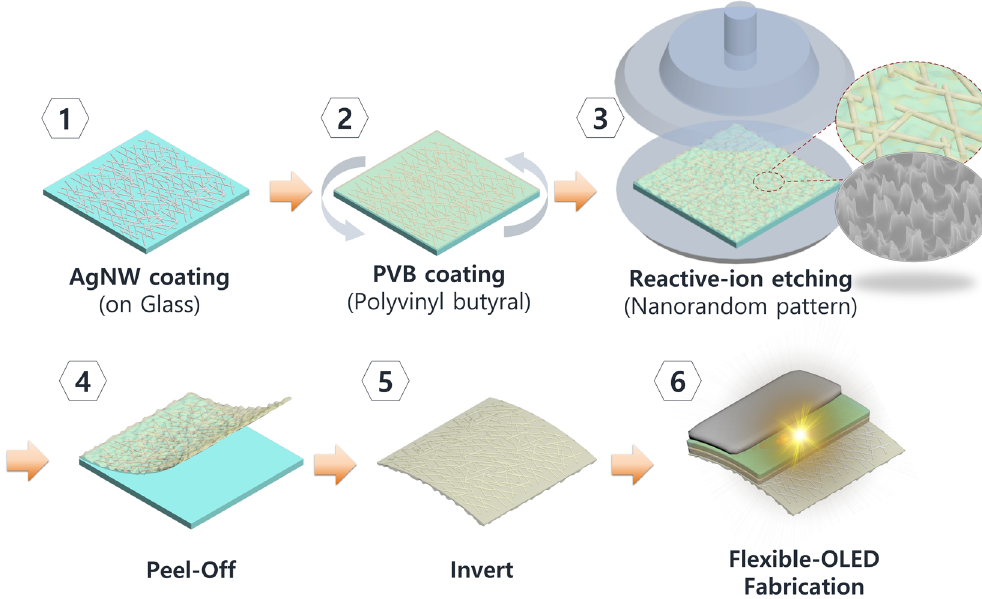
Figure 1. Fabrication procedure of random nanocone (RNC) and PVB/AgNW transparent